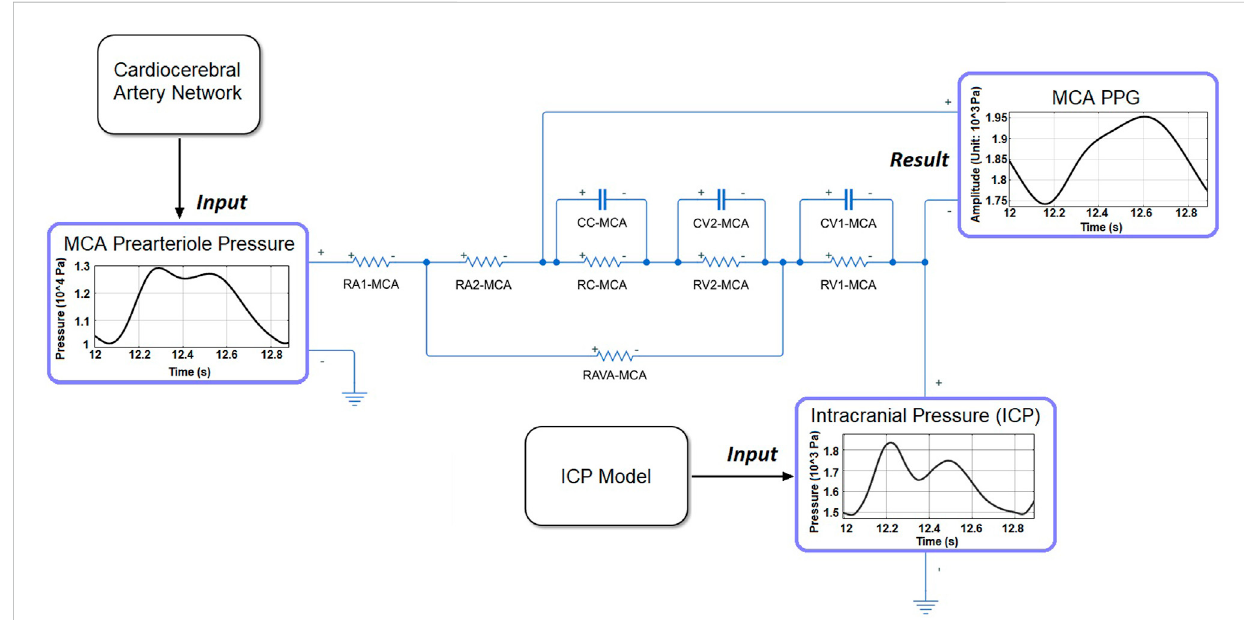
FIGURE 4 The structure of microcirculatory model to generate the PPG signal in MCA territory. RA1-MCA and RA2-MCA: equally divided arteriole resistances. RC-MCA: capillary resistance. RV2-MCA and RV1-MCA: equally divided venule resistances. CC-MCA: capillary capacitance. CV1-MCA and CV2-MCA: equally divided venular capacitances.